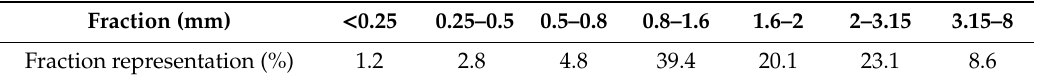
Table 1. Short-cut rapeseed fraction sizes from a sieve analysis.